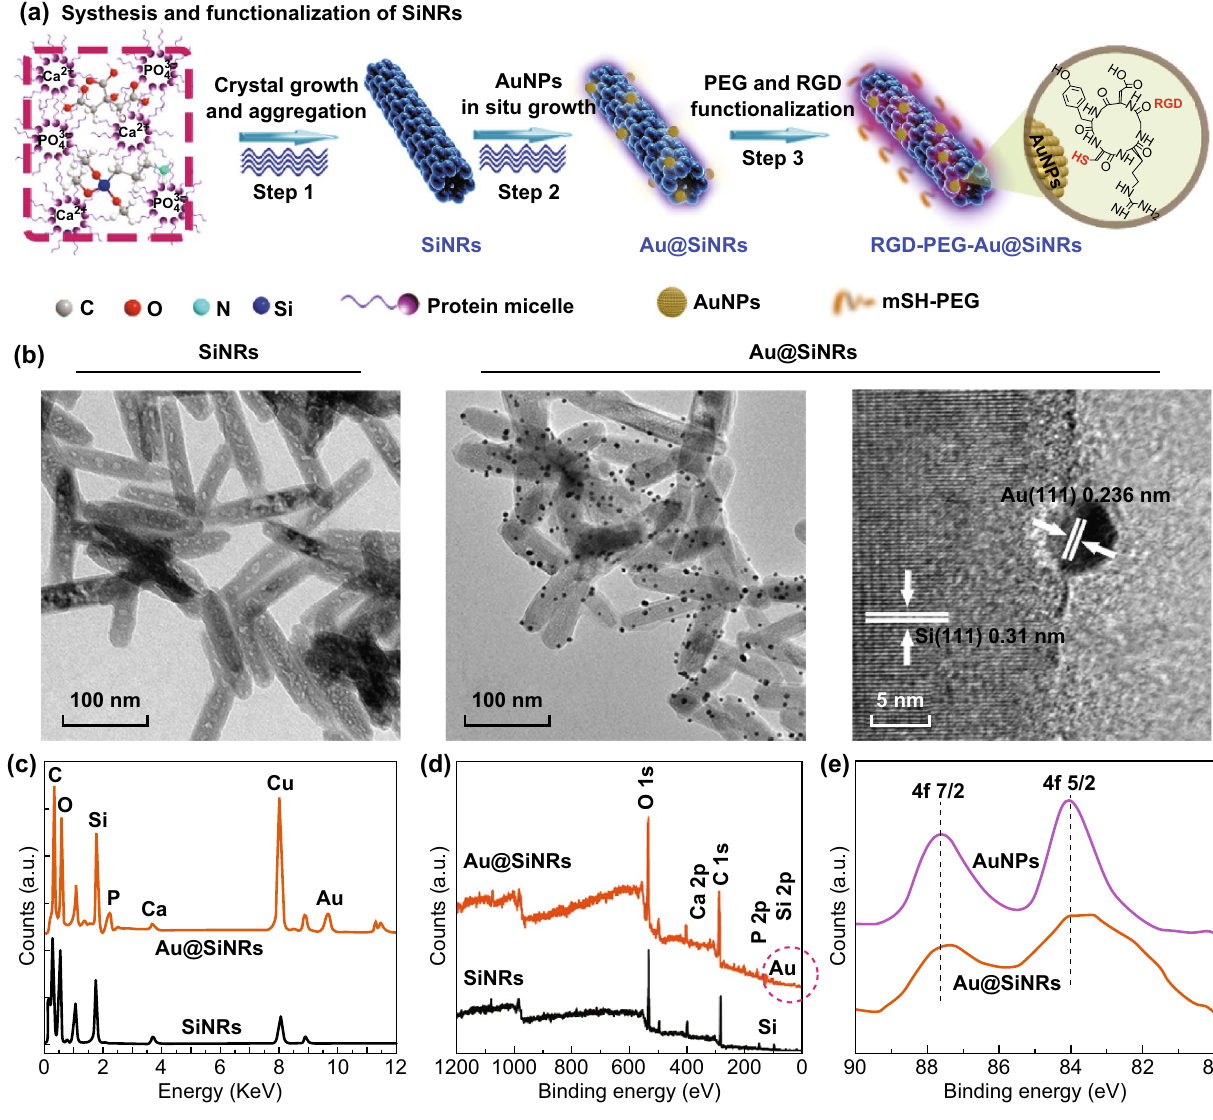
Fig. 1 Schematic illustration of the synthetic procedure and characterization of Au@SiNRs. a The scheme of the fabrication of RGD‑PEG‑ Au@SiNRs, including microwave synthesis of SiNRs, in situ growth of AuNPs on SiNRs, and surface modification of PEG and c(RGDyC). b TEM and HRTEM images of as‑fabricated SiNRs and Au@SiNRs. c EDX spectra of Au@SiNRs (above) and SiNRs (below). d XPS spectra of the as‑prepared Au@SiNRs (blue one) and SiNRs (black one). e Au 4f XPS spectra in AuNPs and Au@SiNRs. (Color figure